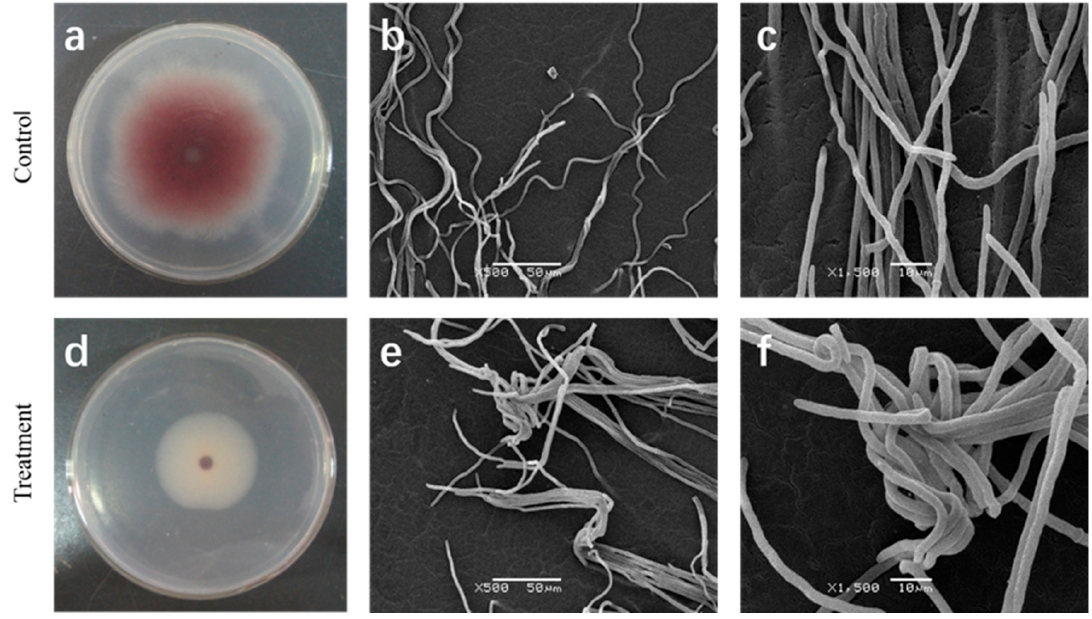
Figure 1. Effect of cuminic acid on mycelia morphology of FON. ( d – f ) Untreated plates; ( a – c ) Plates treated with cuminic acid at EC 50 value (22.53 μ g/mL). Values are means and standard errors.